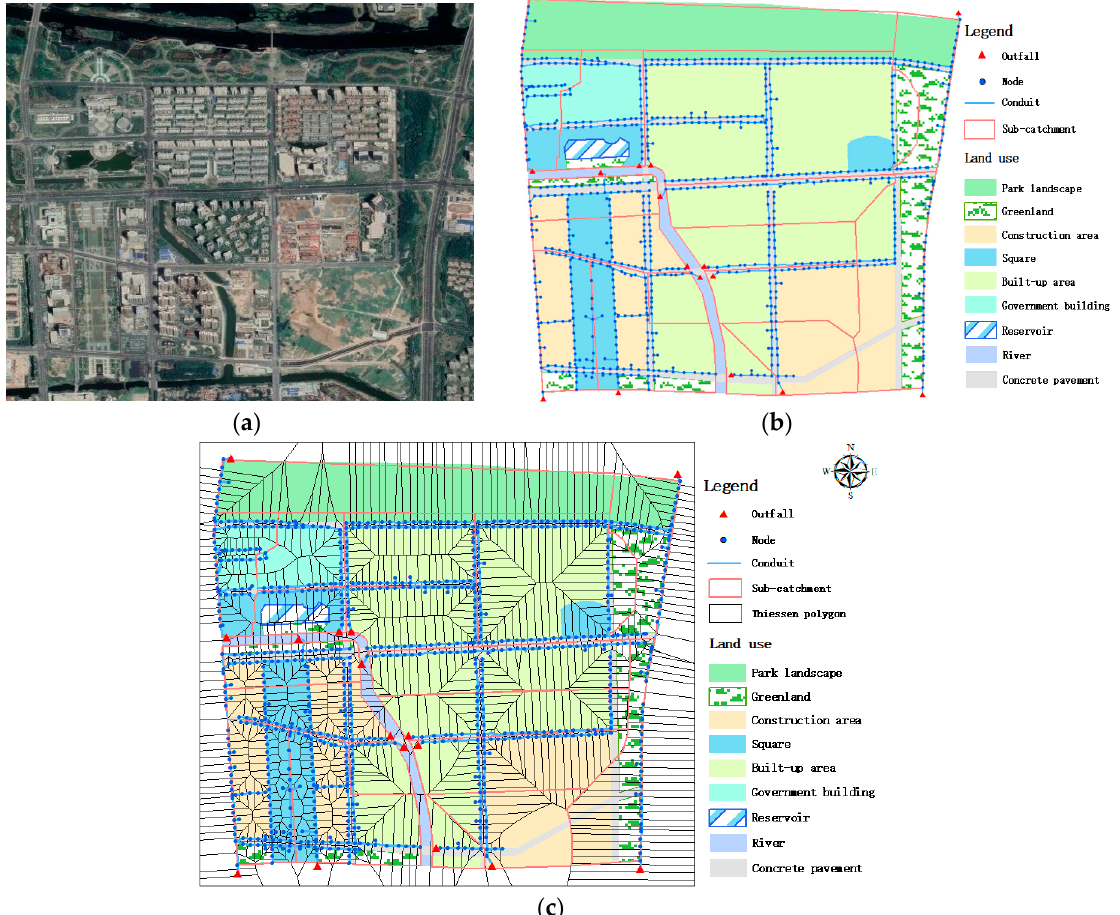
Figure 2. Study area of Sucheng district: ( a ) current condition (from Google maps); ( b ) diagram of the pipe network; ( c ) generalized sketch map of sub-catchments. The scale is about 1:30000.